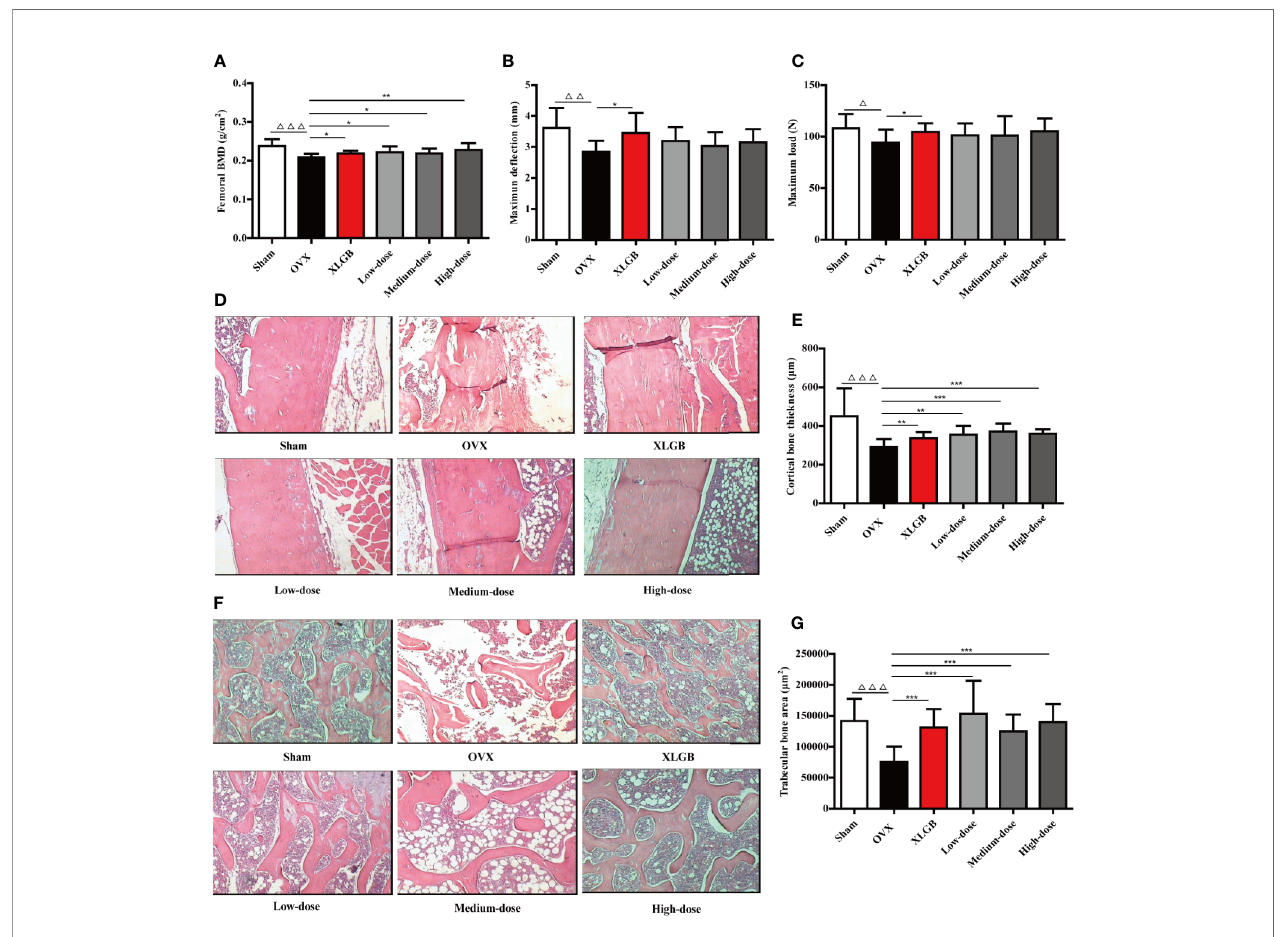
FIGURE 4 | DOE treatment improves bone quality in OVX rats: (A) femoral BMD; (B) maximum de fl ection; (C) maximum load; (D) cortical bone tissue stained with H&E; (E) calculated cortical bone thickness; (F) trabecular bone tissue stained with H&E; and (G) calculated trabecular bone area. Representative images were acquired using a medical image analysis system at an original magni fi cation of ×400. All data are presented as means ± SEM (n = 10). △ P < 0.05, △△ P < 0.01, and △△△ P < 0.001 versus the sham group, and *P < 0.05, **P < 0.01, and ***P < 0.001 versus the OVX